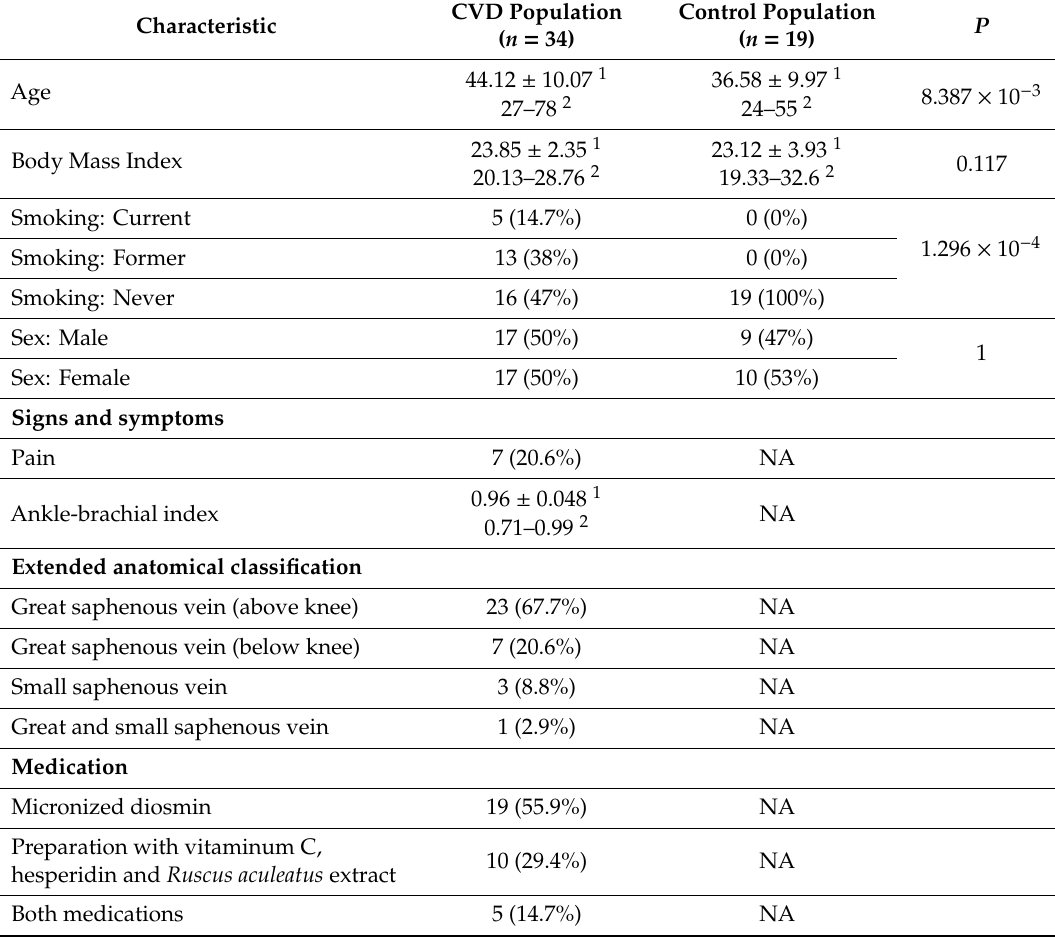
Table 1. Characteristics of 34 patients with chronic venous disease (CVD) and 19 non-CVD controls included in the